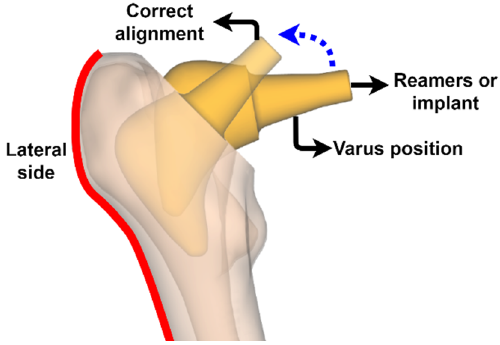
Figure 6. “ Round the corner” technique.